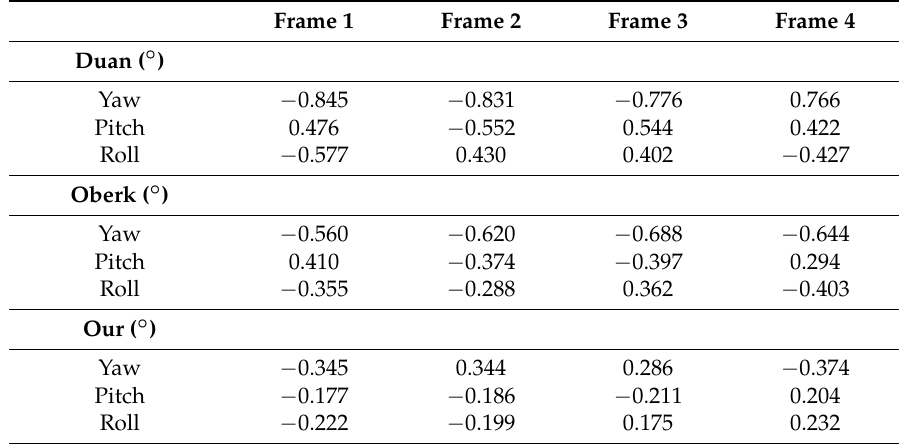
Figure 12. The image sets of head pose. Table 4. The measurement errors of head